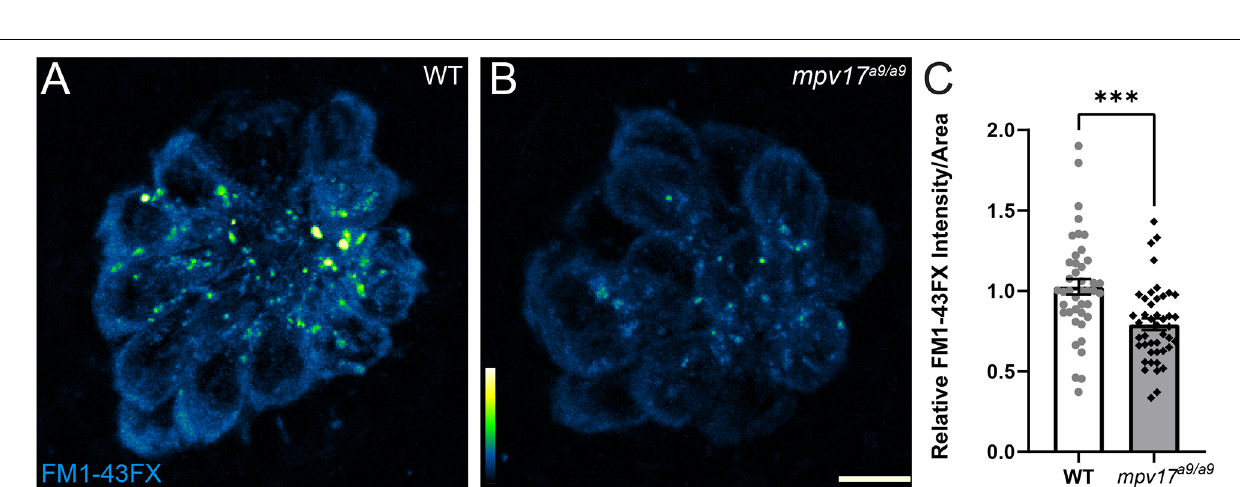
FIGURE 3 | FM1-43 uptake is reduced in mpv17 a9/a9 hair cells. (A,B) Maximum-intensity projections of confocal images showing WT (A) and mpv17 a9/a9 (B) neuromasts exposed to FM1-43FX. (C) Mean intensity of FM1-43FX is reduced in mpv17 a9/a9 neuromasts ( ∗∗∗ P = 0.0002). n = 42–44 neuromasts (L3, L4, and L5); N = 4 experimental trials. Scale bar: 5 µ m. Error bars: